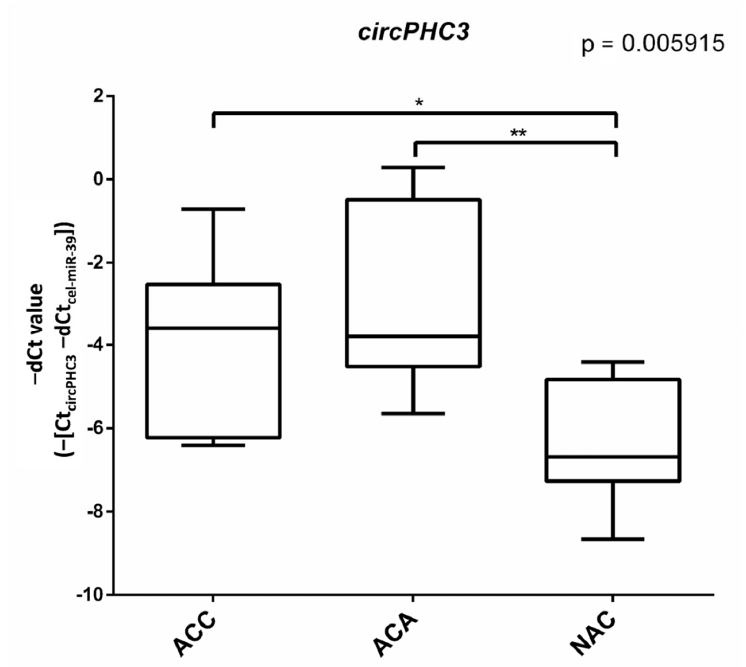
Figure 3. Box plot representing the expression of circPHC3 in ACA, ACC, and NAC samples. ANOVA ( p = 0.005915) and Tukey post ‐ hoc tests (*: p < 0.05, **: p < 0.01) were performed.